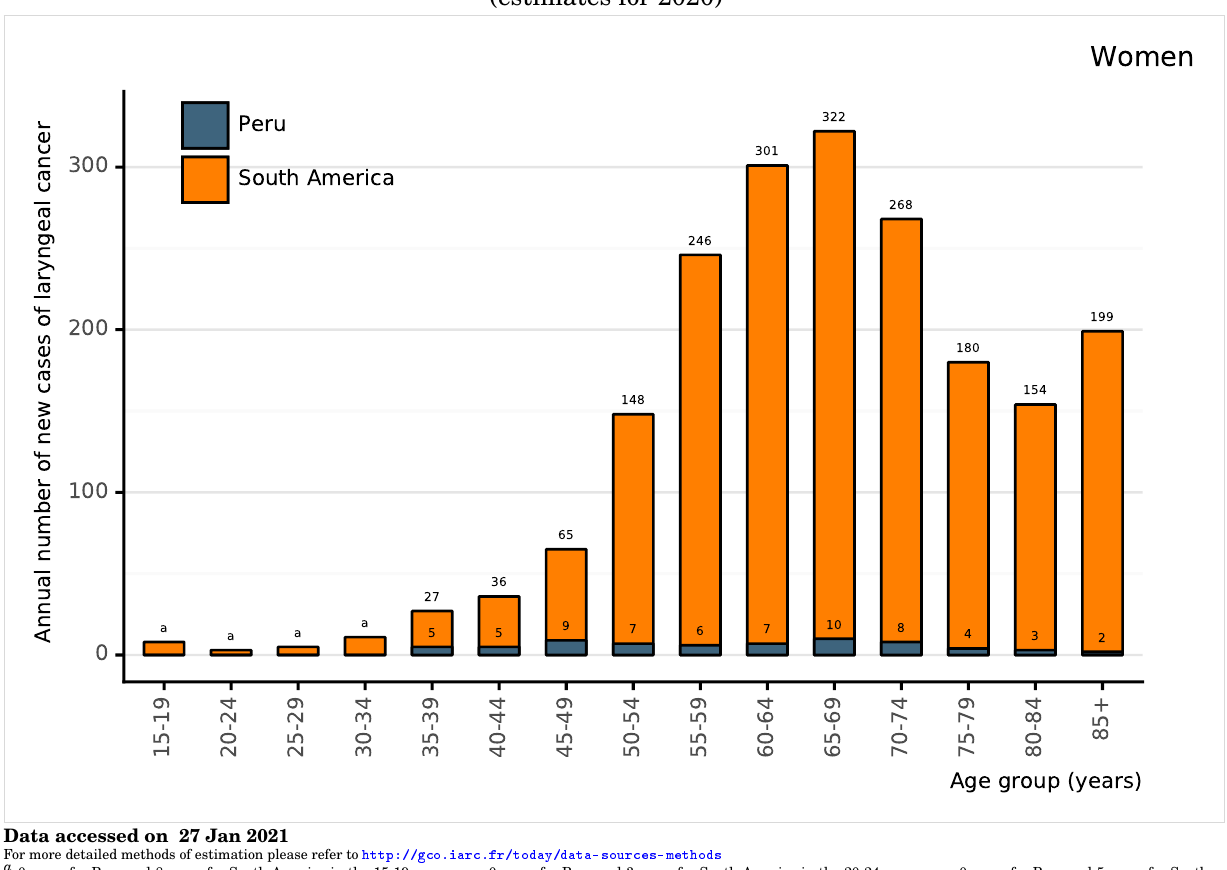
Figure 102: Annual number of new cases of laryngeal cancer among women by age group in